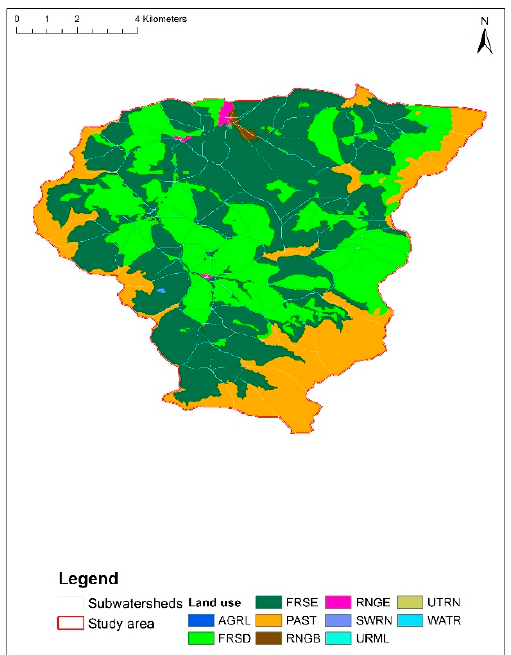
Figure 2. Land use (AGRL—Agricultural land; FRSD—Forest deciduous; FRSE—Forest evergreen; PAST—Mountain meadow; RNGB—Pasture with trees; RNGE—Meadows; SWRN—Rocky lands; URML—Built-up areas; UTRN—Roads; WATR—Water body) categories distribution within the Upper Tarlung watershed.